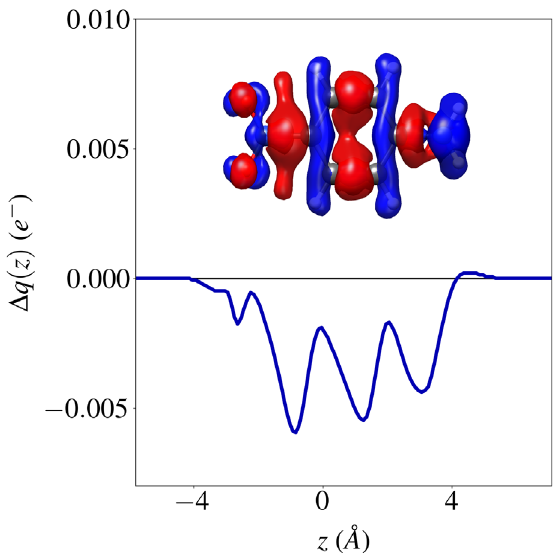
FIG. 3. QED-CCSD-1 ground-state density difference induced in PNA by an optical cavity ( λ ¼ 0 . 05 and ω the corresponding charge displacement analysis. The blue and red regions represent charge accumulations and depletions. The isosurface value is (cid:5) 5 × 10 − 5 e − a : u : 3